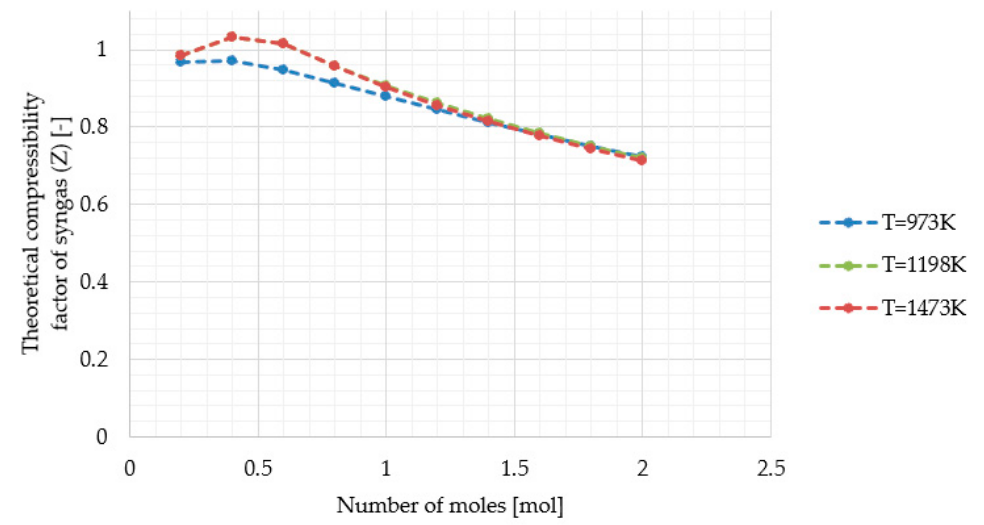
Figure 13. The theoretical value of the compressibility coefficient Z from the gasification of H 2 O. For the gasification of SS with air, the highest value of the B syn coefficient was 262.26 for one mole of oxygen from air per mole of carbon at 1473 K. The smallest value of the coefficient of 184.26 was obtained for 0.2 mole of oxygen from air at 1473 K. The highest energy content in the transport unit was 19,916.74 MJ for 0.1 moles of H 2 O per mole of carbon at 973 K, the smallest being 5,508.56 MJ for one mole of oxygen from air per mole of carbon at 973 K (Figures 14–16).